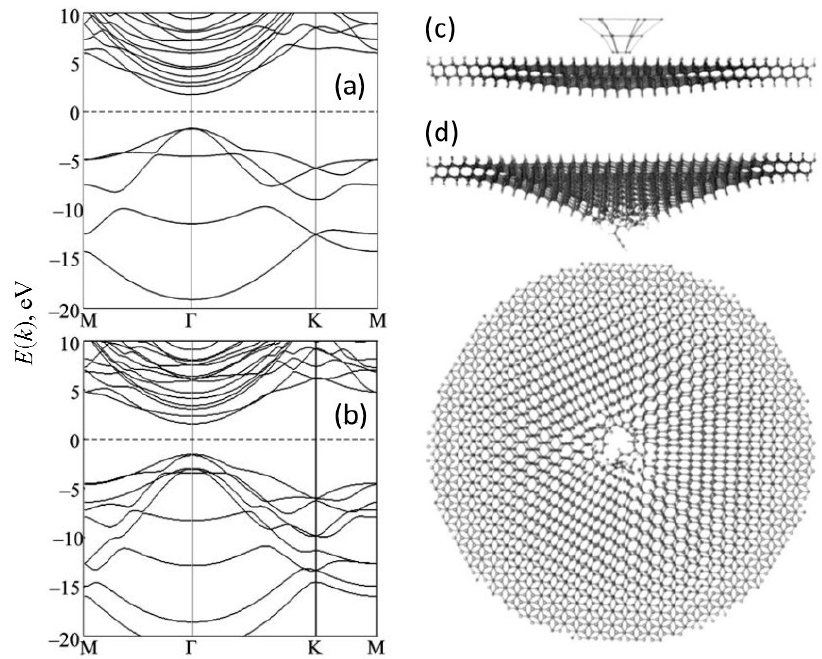
Figure 2. Band structures of ( a ) graphane, CH, and ( b ) diamane, C 2 H, (the Fermi level is taken as zero) and the dynamics of the diamane membrane’s deformation; ( c ) elastically deformed structure and ( d ) membrane break.